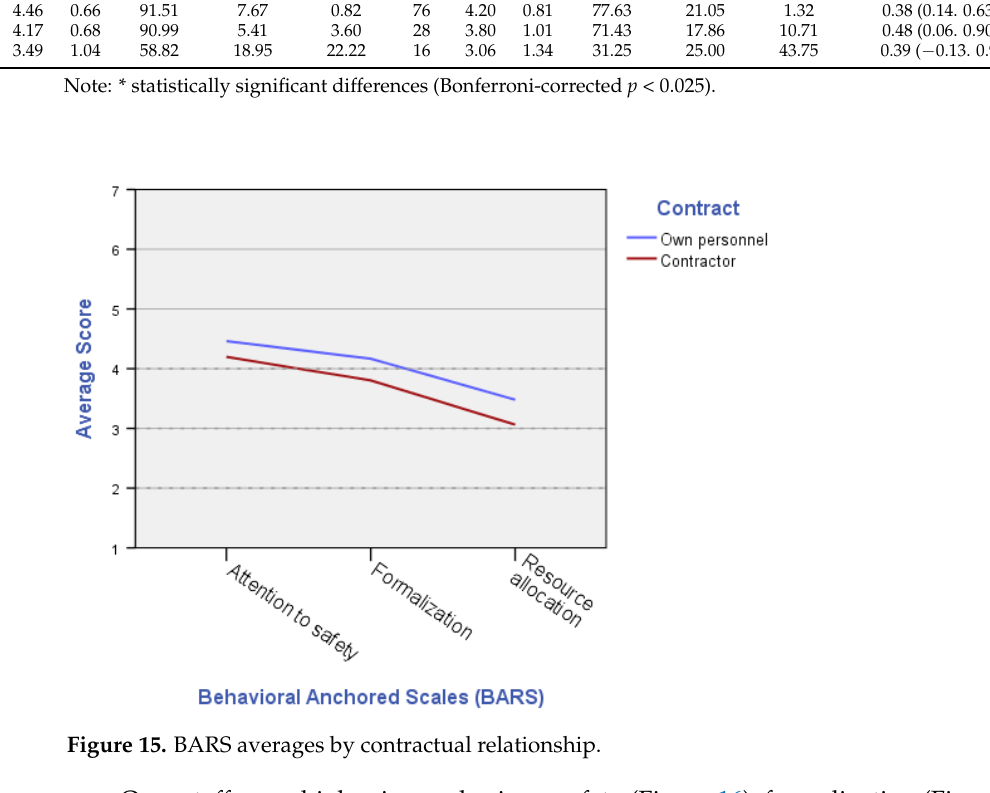
Figure 16. Categorized BARS percentages for attention to safety, by contractual relationship.